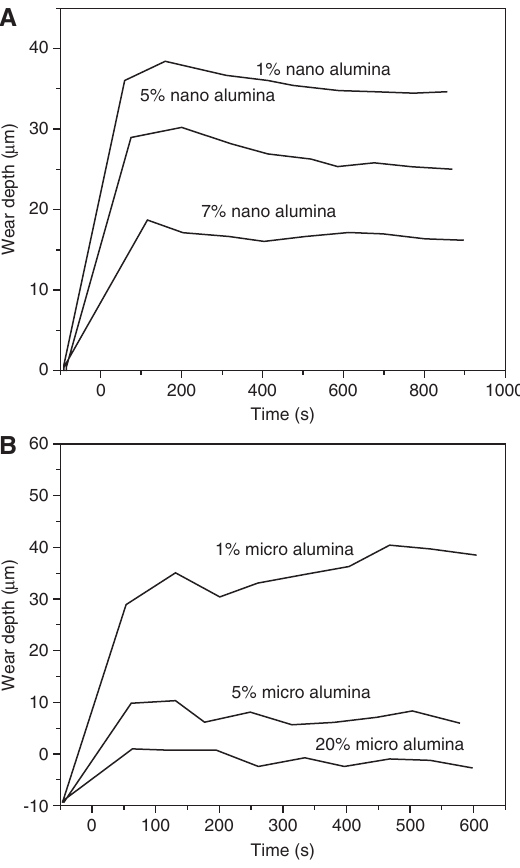
O nanocomposites 2 3 O microcomposites and (B) elastic 2 3 O nanocomposites fabricated by SPS. 2 3